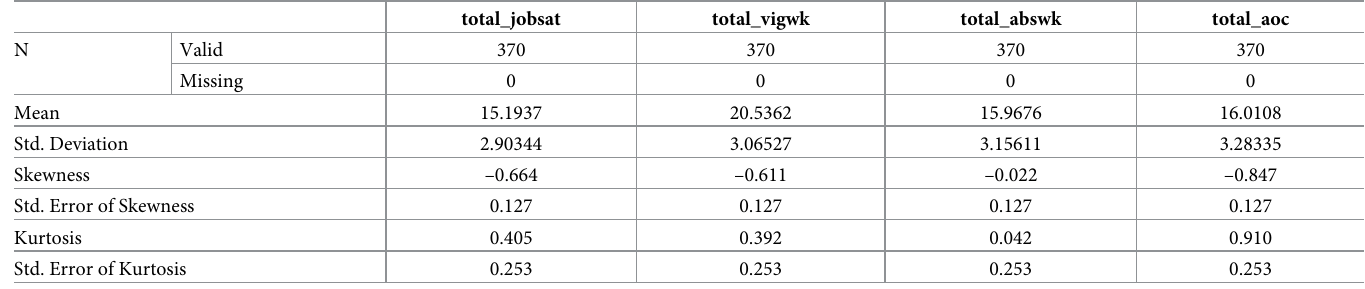
Table 2. The description of happiness at work